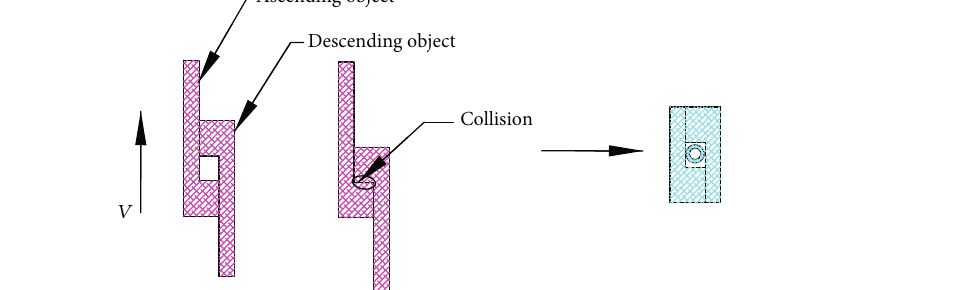
Figure 2: Finite element model.